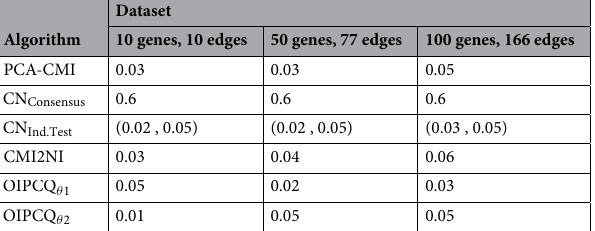
Table 1. Threshold values for methods used on three sets of DREAM3-Yeast1-null-mutant dataset.